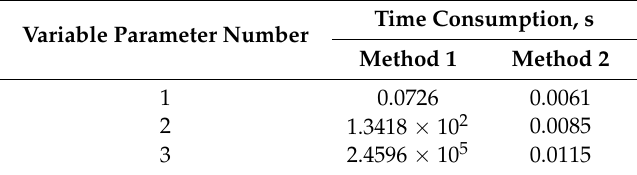
Table 4. Time consumptions with the enlargement of variable parameter number.